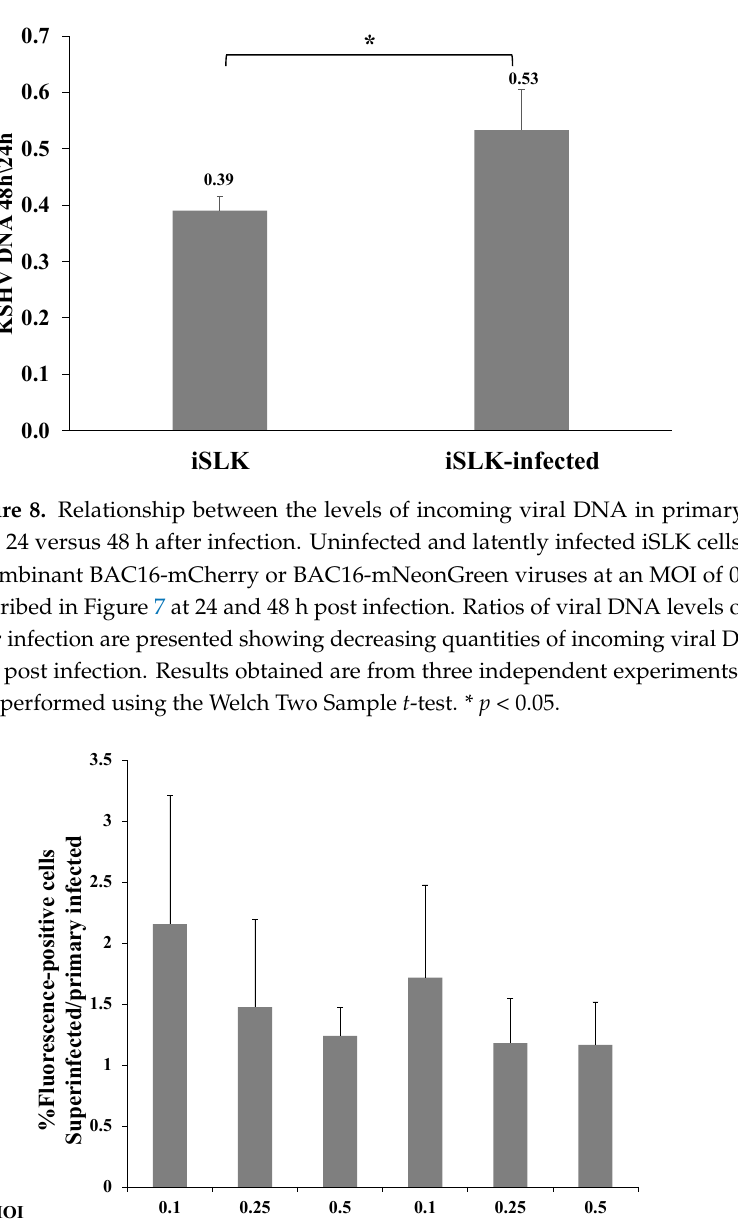
Figure 7. Superinfected cells contain higher levels of incoming viral DNA compared to primary infected cells. Uninfected and latently BAC16-mCherry-infected iSLK cells were infected with BAC16-mNeonGreen at MOI of 0.25 and 0.5 using the spinoculation method. High-molecular- weight DNA was extracted 48 h after infection, and the quantity of incoming viral DNA was meas- ured using primers targeting the mNeonGreen fluorescent gene. The reactions were performed in triplicate, and the mean values obtained for the mNeonGreen fluorescent gene were normalized against the mean values obtained in the corresponding reactions of the ERV-3 cellular gene. DNA levels are shown relative to iSLK cells that were infected with BAC16-mNeonGreen virus at an MOI of 0.25, which was defined as 1 after normalization. Results obtained are from three independent experiments. Statistical analysis was performed using the ANOVA test and t -test. ** p < 0.01.